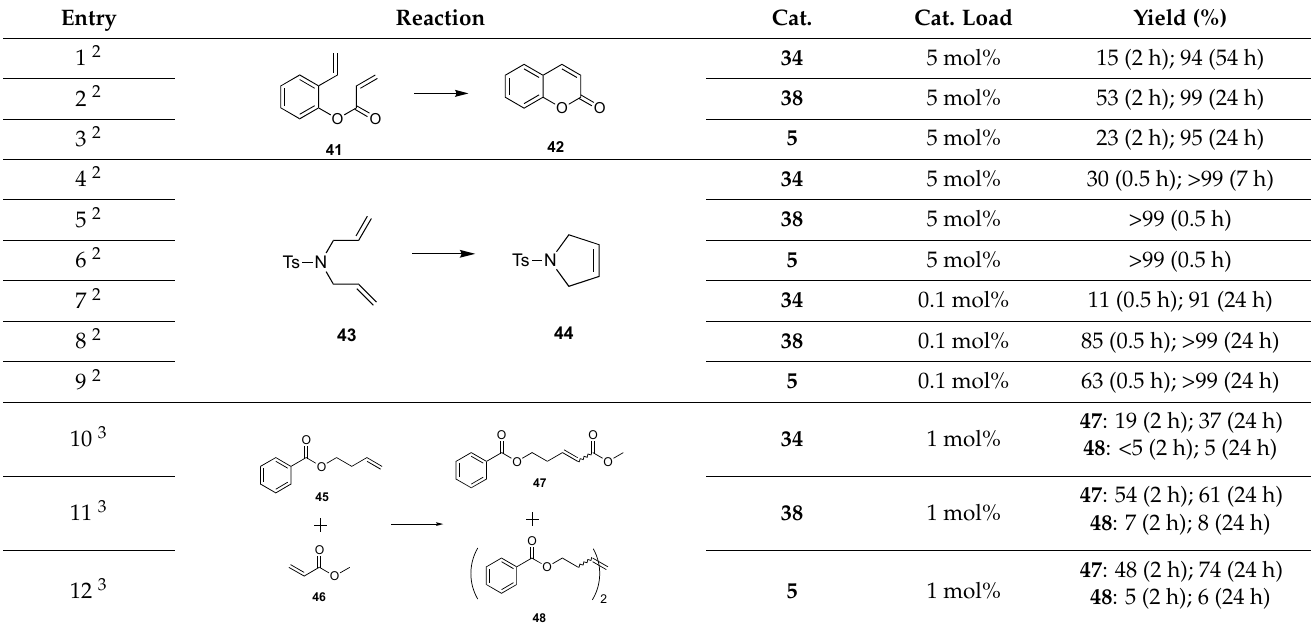
Table 5. Catalytic activities of HG-II ( 5 ), complexes 34, and 38 1 [65].